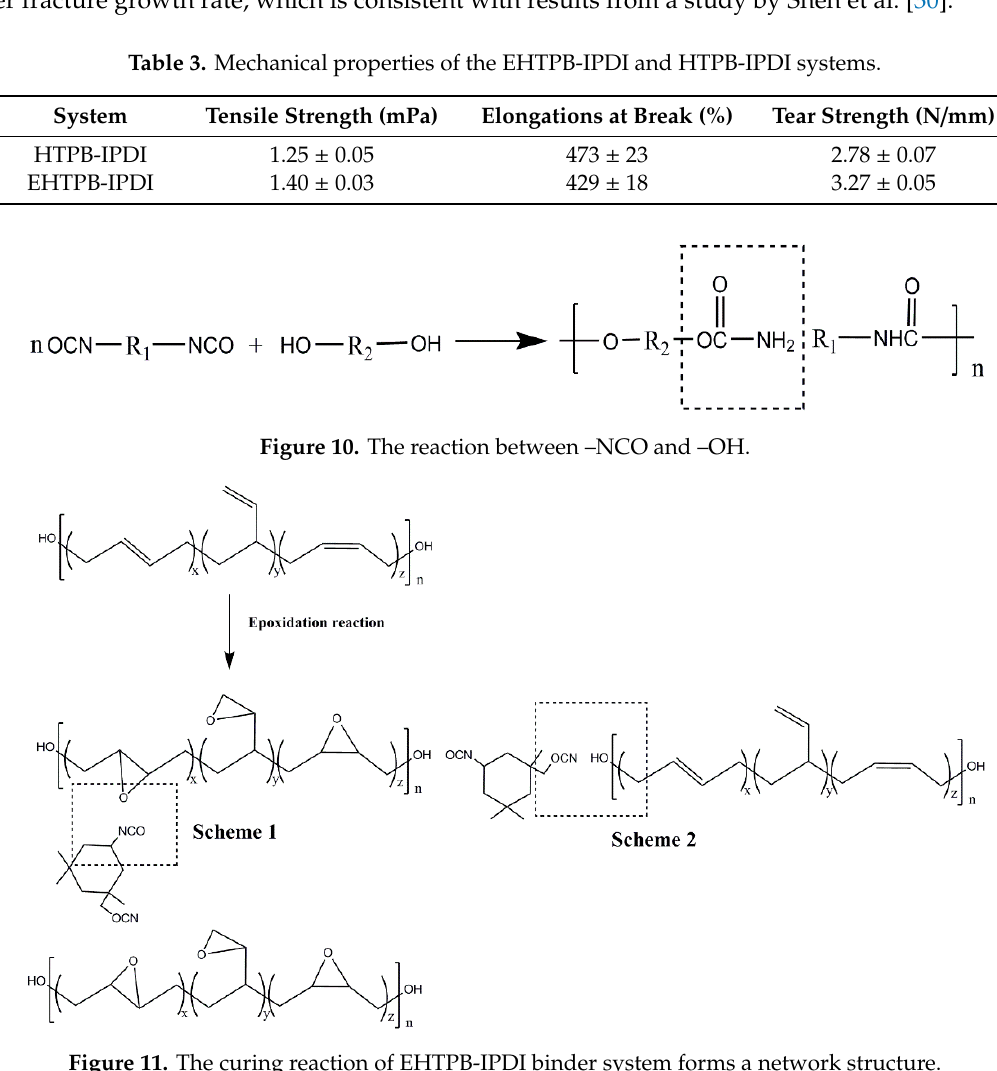
Figure 11. The curing reaction of EHTPB-IPDI binder system forms a network structure.